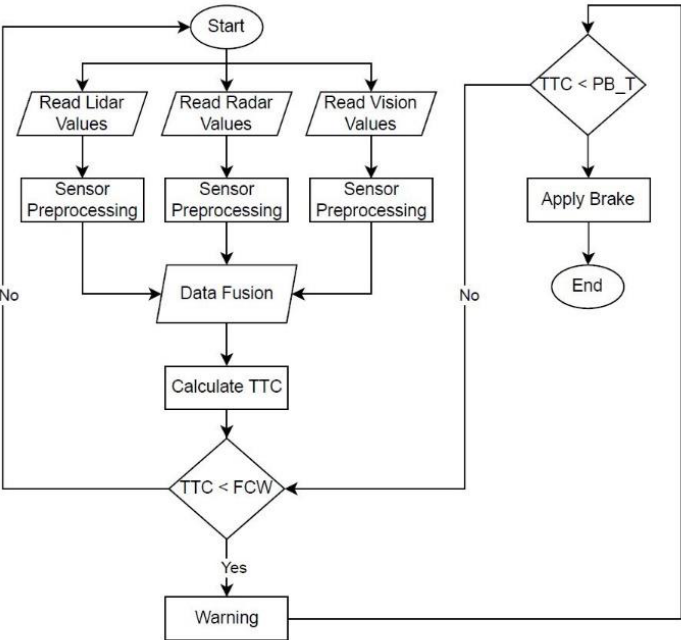
Figure 5. Flow chart of AEB with sensor fusion.